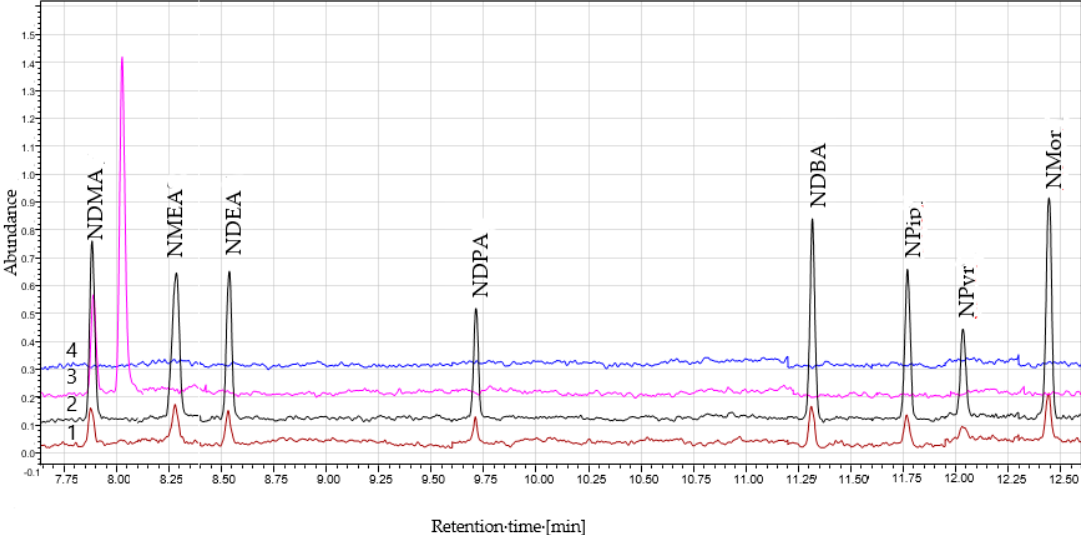
Figure 1. The chromatograms of ( 1 ) the N-nitrosamines (NAs) standards (1.0 ng/mL); ( 2 ) the NAs standards (5.0 ng/mL); ( 3 ) the sample solution; ( 4 ) the blank solution.